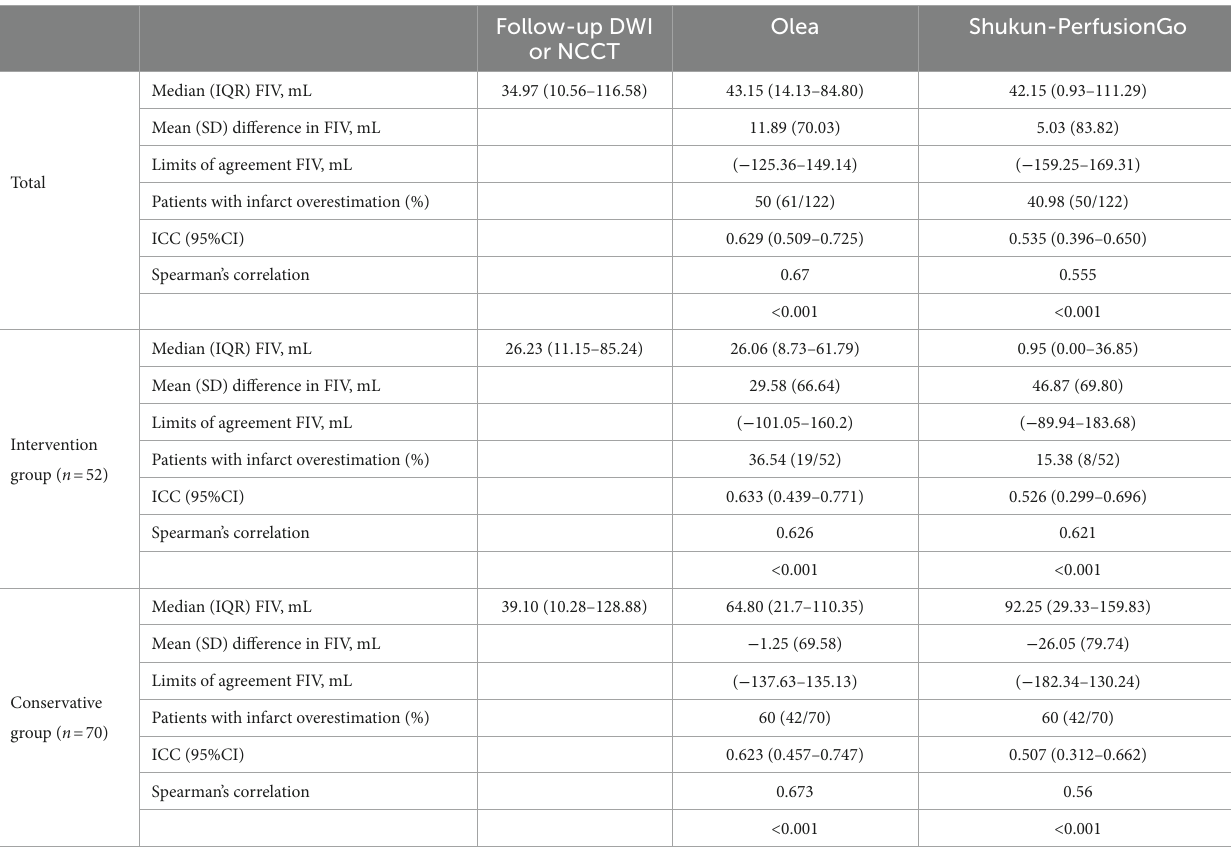
TABLE 3 Correlation between the predicted final infarct volume (FIV) from Olea/PerfusionGo and true FIV from follow-up DWI/NCCT.